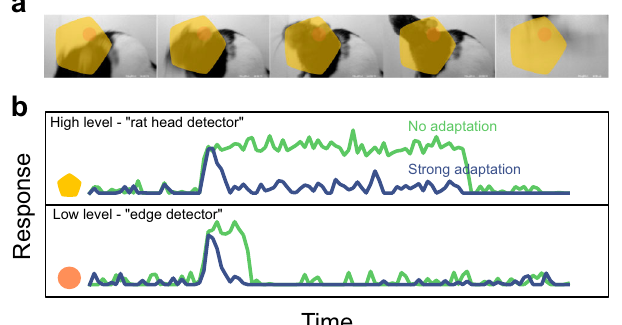
Fig. 1 Effect of adaptation on the response timescale of high- vs. low- level feature detectors (cartoon). a Dynamical visual stimulus (movie frames). Orange dot, yellow shape: idealized receptive fi eld of a low-level feature detector neuron ( “ edge detector, ” orange) and a high-level feature detector ( “ rat head detector, ” yellow). b Single-trial response of the two example neurons, when adaptation is absent (green trace) and when adaptation is strong (blue trace). Note how adaptation shortens the timescale of the